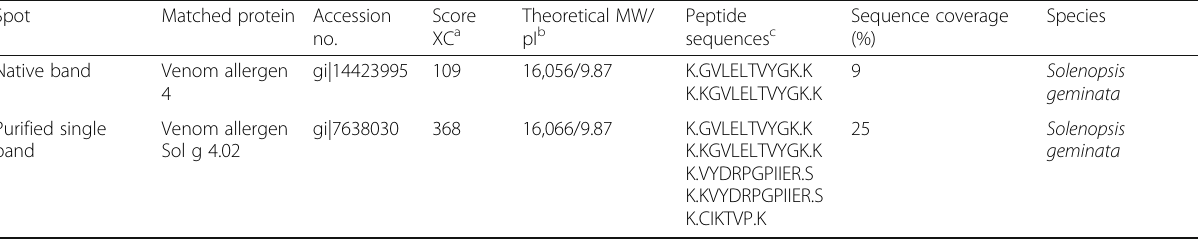
Table 2 Protein identification of Sol g 4.1 from S. geminata venom Spot Matched protein Accession no.